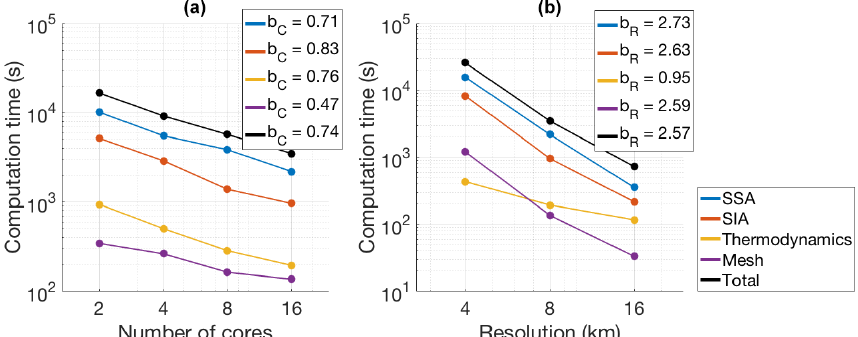
Figure 12. (a) Computation times vs. number of cores for the SSA (blue), SIA (red), thermodynamics (yellow), and mesh updating (purple) model components, as well as for the entire model (black), for a 10000-year Antarctic retreat simulation at 8km resolution. These four components together account for ∼ 99 . 8% of the total computation time. Logarithmic fits of the form ln t = a + b C ln C have been made to the data, with the scaling coefficients b C shown in the legend. (b) Computation times vs. model resolution for the same model components, run on 16 cores. Logarithmic fits of the form ln t = a + b R ln R have been made to the data, with the scaling coefficients b C shown in the legend.